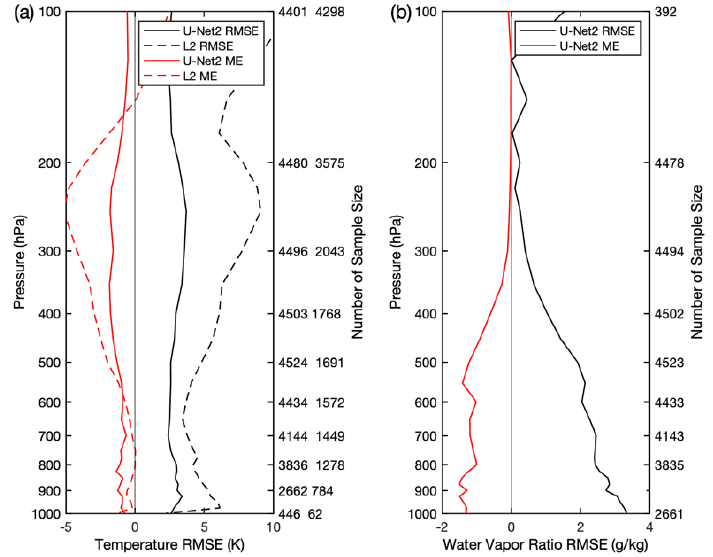
Figure 17. Same as Figure 16 except for all sky: ( a ) temperature retrieval error profiles; ( b ) water vapor mixing ratio retrieval error profiles.